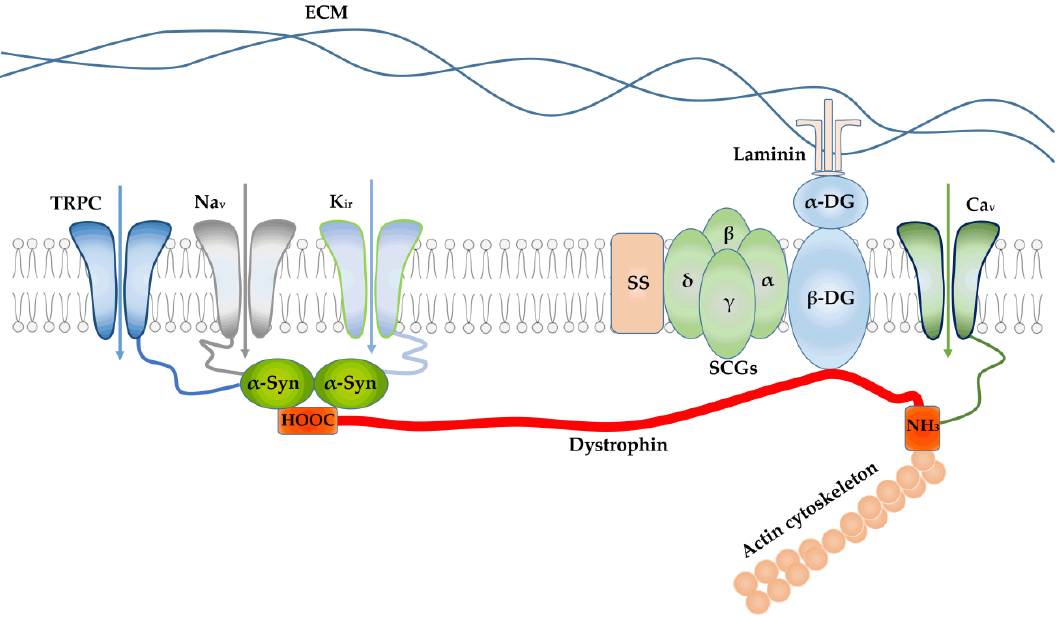
Figure 1. Association of a DAPC with ion channels of the sarcolemma, cytoskeleton, and extracellular matrix. ECM—extracellular matrix, α -DG— α -dystroglycan, β -DG— β -dystroglycan, SCGs—sarcoglycans, α -Syn— α -syntrophin, SS—sarcospan, TRPC—transient receptor potential channel, Ca V —voltage-gated calcium channel, Kir—inward-rectifier potassium channel.